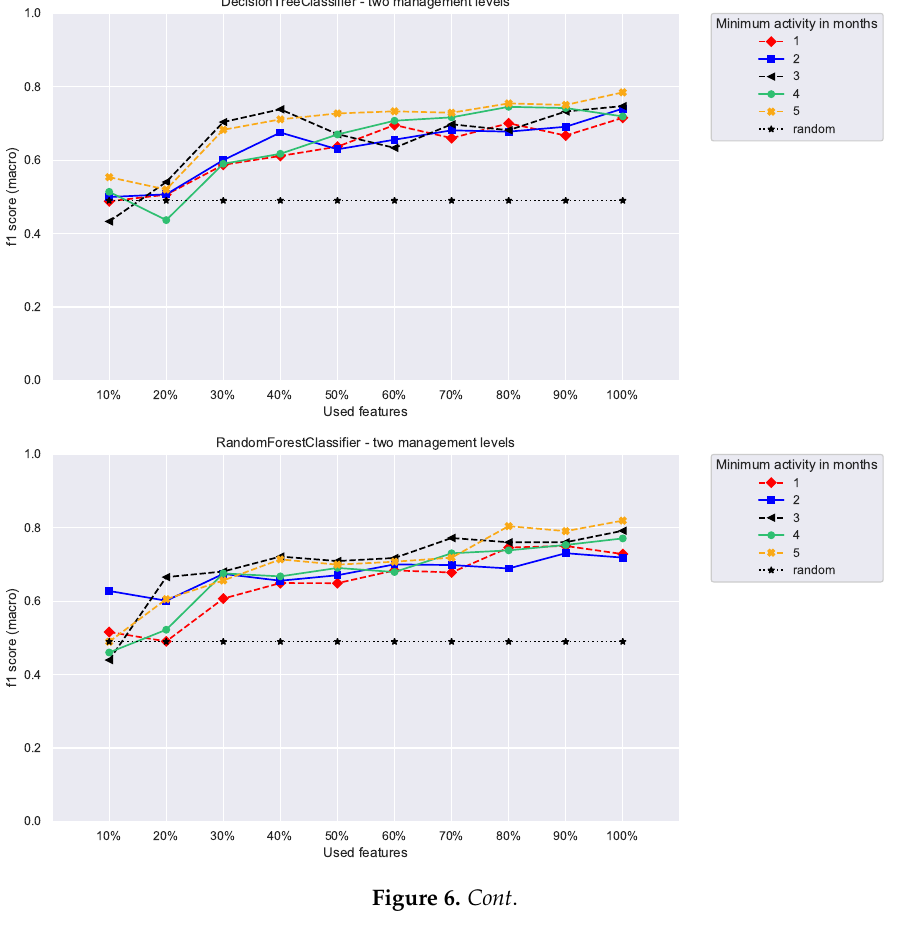
Figure 5. The result of the collective classification of three groups for the manufacturing company dataset.